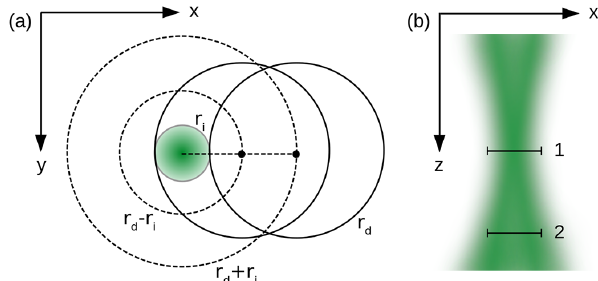
Figure 7. (a) Expected radii for maximum ( r d − r i ) and partial counts ( r d + r i ) in the signal map for an image of radius r i and a diaphragm (solid line) of radius r d for r i < r d . (b) Schematic longi- tudinal view of radiation intensity near the focal plane, diaphragm in a focused (1) and in an out-of-focus (2)